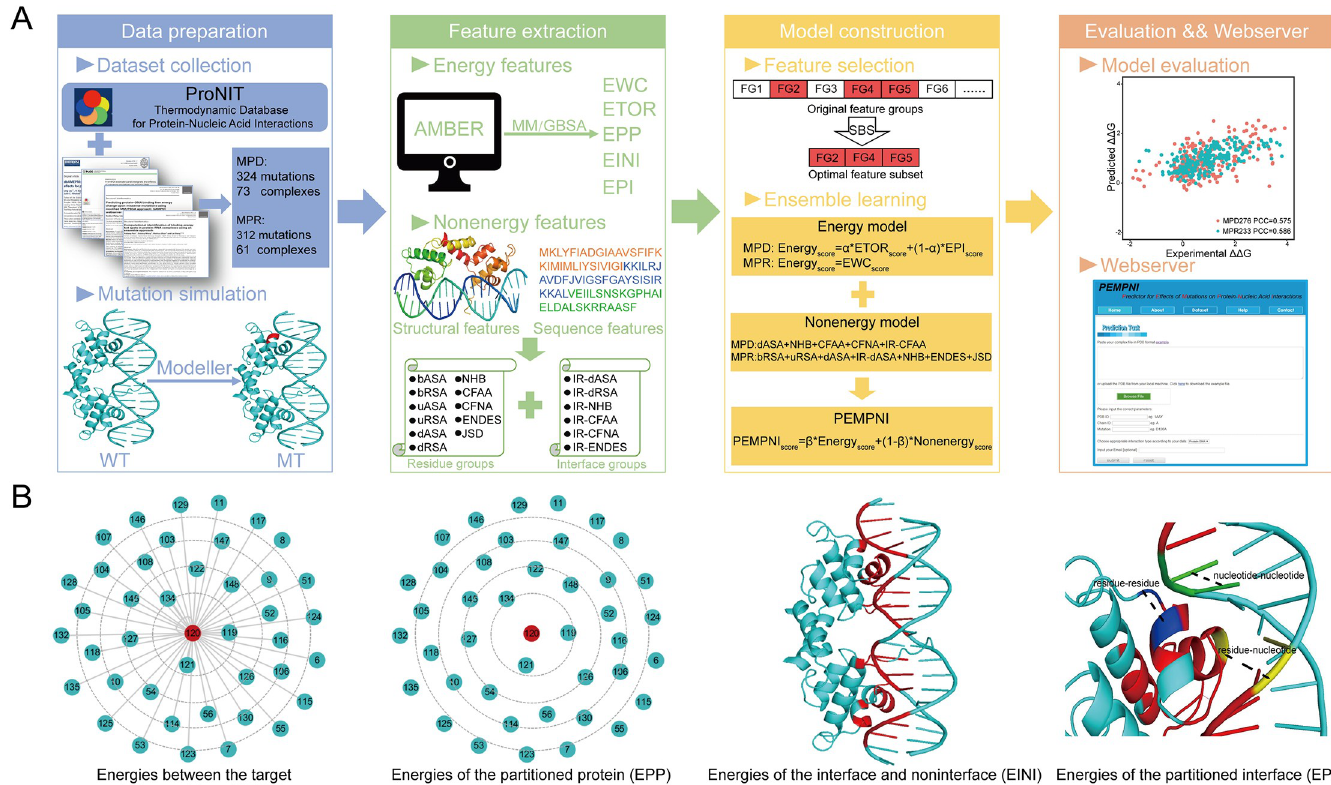
Fig 1. Schematic illustration of PEMPNI and novel energy features. (A) Flowchart of our computational framework. (B) Geometric partition-based energy features.